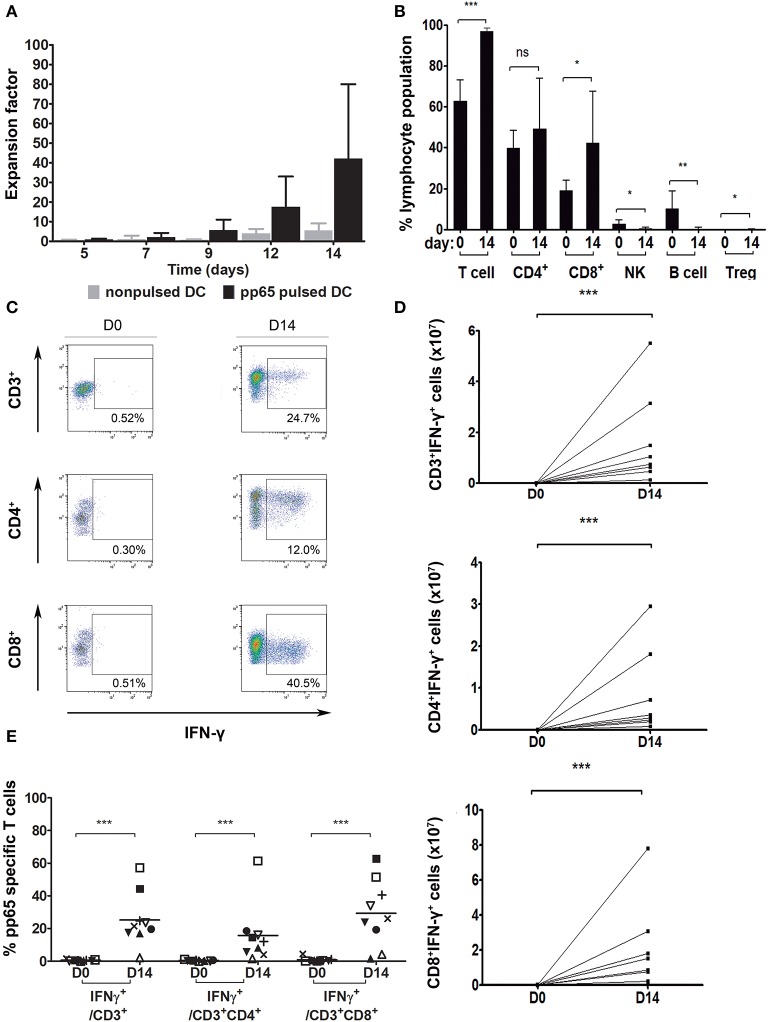
Pp65-specific T cell expansion. (A) Number of total cells at different time points during the 14-day culture. PBMC cocultured with: pp65 peptide pool-pulsed DC (black, n = 9) and nonpulsed DC (gray, n = 4). (B) Percentage of general cell subpopulations pre- (day 0) and post-expansion (day 14). T cells: CD3+, CD4+: CD3+CD4+, CD8+: CD3+CD8+, NK: CD3−CD56+, B cell: CD3−CD19+CD20+, Treg: CD3+CD4+CD25+FOXP3+ (n = 9). (C) Gating strategy for IFN-γ secreting cells from one representative donor. Dot plots show the response of T lymphocytes against pp65 antigen stimulation. (D) Number of VST at day 0 and after the 14-day culture (n = 8). (E) Percentage of IFN-γ secreting population cells at days 0 and 14 of culture (n = 9). *p < 0.05, **p < 0.01 and ***p < 0.001 (Mann-Whitney test).